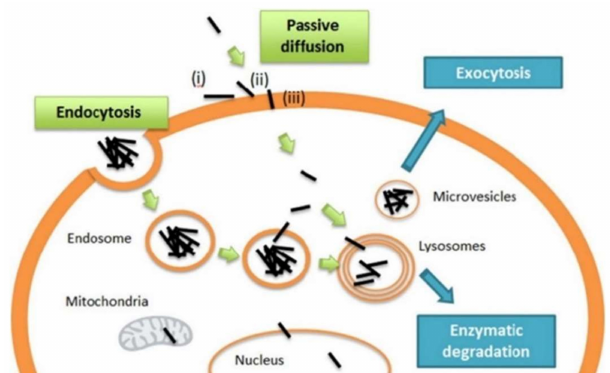
Figure 3. General representation of the main mechanisms involved in the CNT cellular uptake. Reproduced with permission from [137] Elsevier (2016).